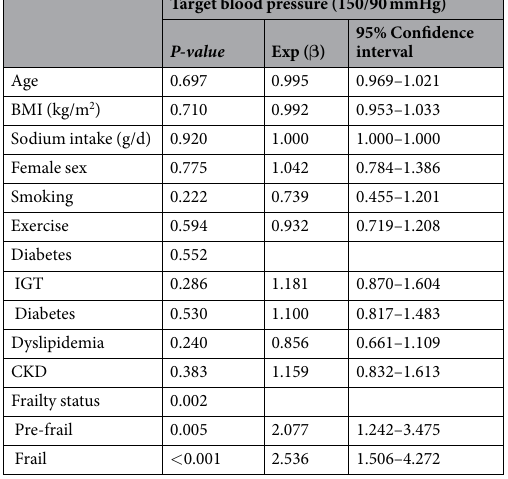
Table 3. Binary logistic regression analysis: factors associated with blood pressure control (target blood pressure: 150/90 mmHg). BMI: body mass index, IGT: impaired glucose tolerance (5.4 mmol/L (100 mg/dL) ≤ fasting blood sugar ≤ 6.9 mmol/L (125 mg/dL)), CKD: chronic kidney disease, Dyslipidemia: either hypercholesterolemia, hypertriglyceridemia, low HDL-cholesterolemia, or a combination. (Hypercholesterolemia: 12 h-fasting total cholesterol ≥ 6.22 mmol/L (240 mg/dL) or taking hypercholesterolemia medications, Hypertriglyceridemia: 12 h-fasting triglyceride ≥ 2.27 mmol/L (200 mg/dL), Low HDL-cholesterolemia: 12 h-fasting HDL-cholesterol < 1.04 mmol/L (40 mg/dL)).